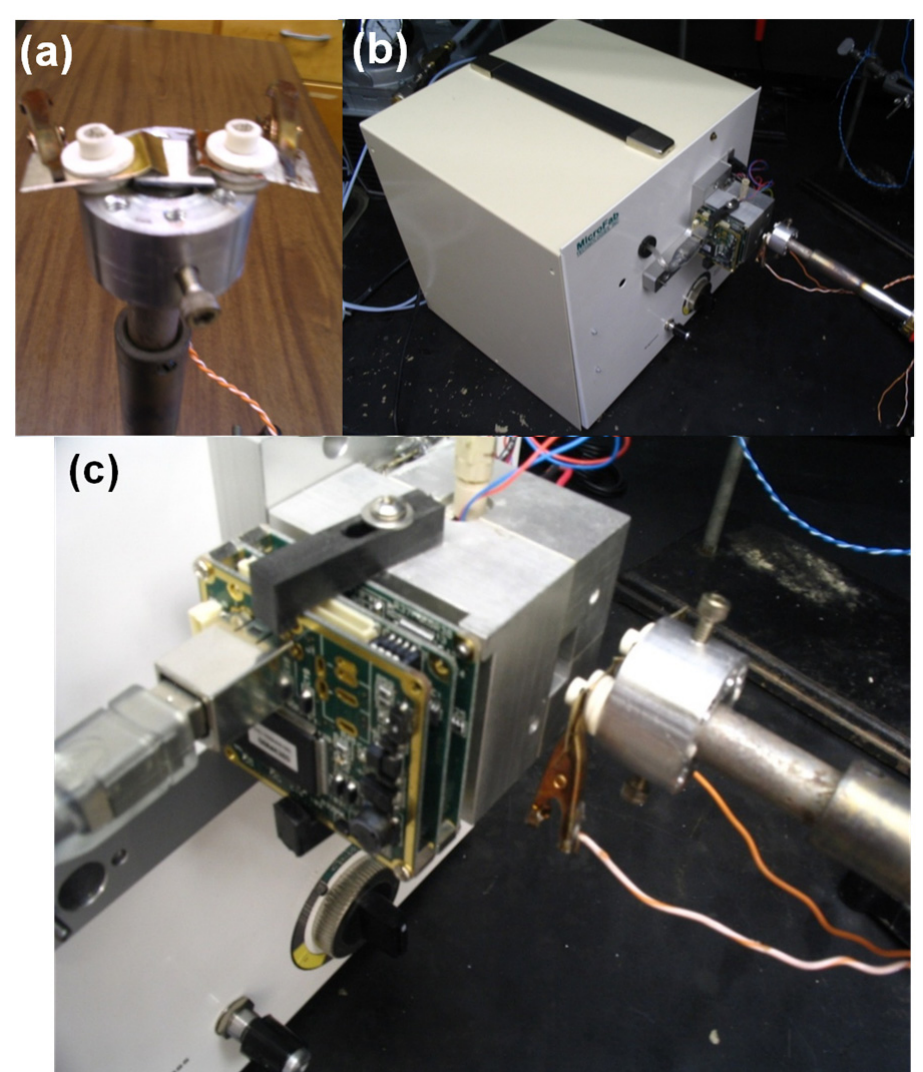
Figure 2. Images of the experimental setup: ( a ) the sensor holder, ( b ) the sensor holder in front of the output of the VaporJet, and ( c ) a close up view of the sensor holder in front of the